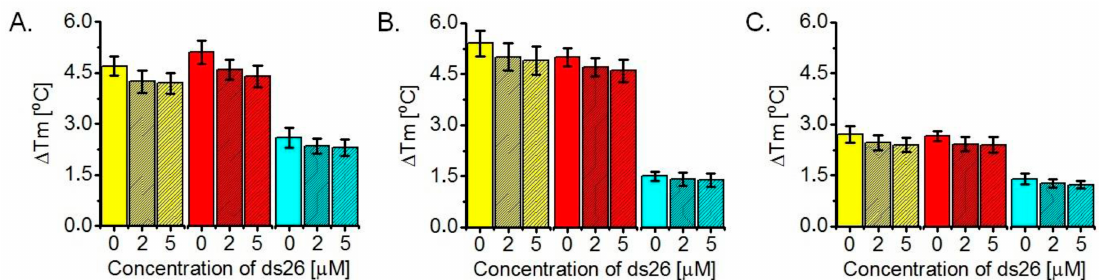
Figure 4. Values of Δ T m for ligand interaction with F21T/K + ( A ), F21T/Na + ( B ) and FmycT/K + ( C ), determined via FRET melting assays. Ligands 14 (yellow), 13 (red) and 10 (cyan) were tested at 1 µM final concentration, with the G4-DNA fixed at 0.2 µM and the competing ds26 duplex DNA at 0, 2 or 5 µM. Buffer used was 10 mM lithium cacodylate (pH 7.2), supplemented with: 90 mM LiCl/10 mM KCl in ( A ); 90 mM LiCl/10 mM NaCl in ( B ); and 99 mM LiCl/1 mM KCl in ( C ).